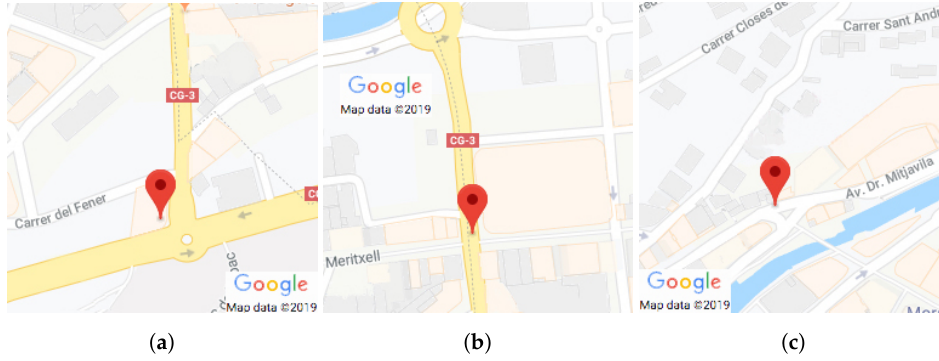
Figure 2. The images above show the three places where the recordings took place from a satellite perspective from Google maps (map data: Google 2019). ( a ) Ctra. de l’Obac, 19; ( b ) Av. Carlemany, 121; ( c ) Av. Meritxell,